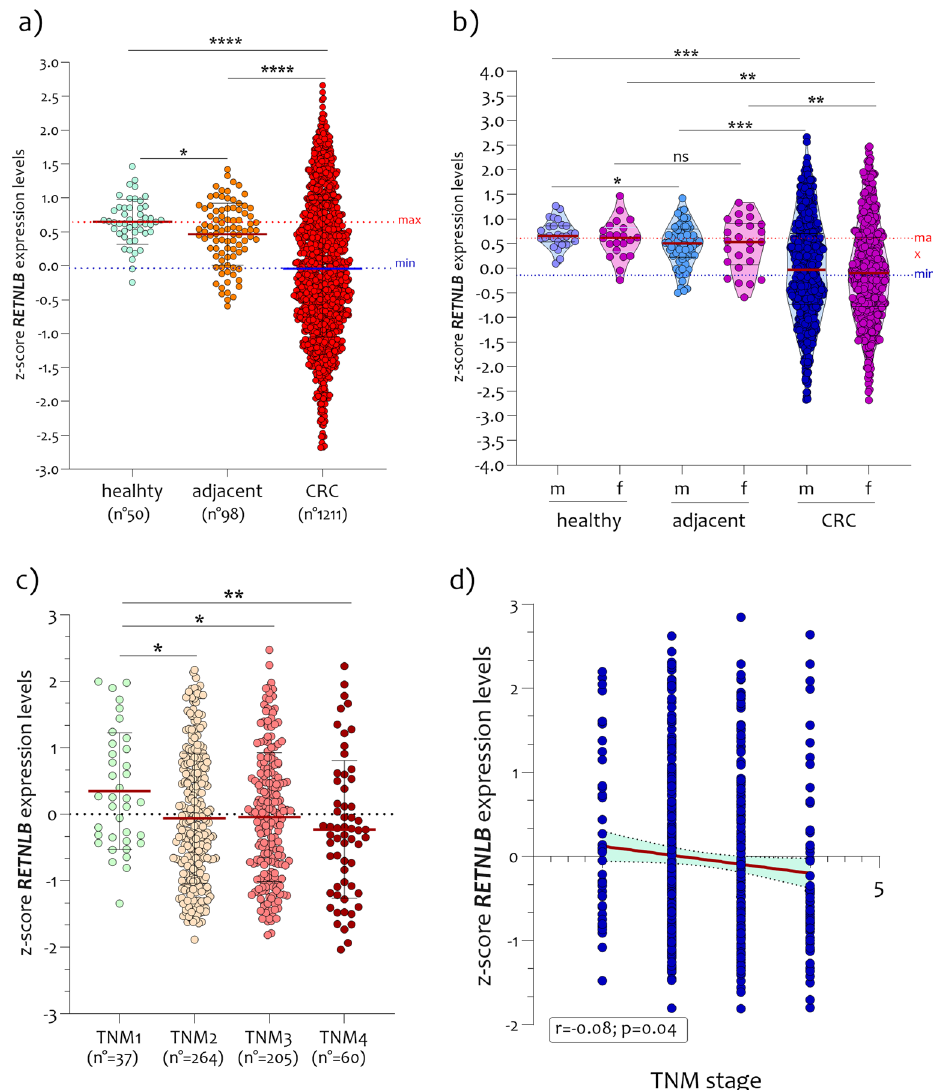
Figure 1. Expression levels of RETNLB in CRC datasets. ( a ) Reduction of RETNLB expression in CRC biopsies compared to NHM and NPDM; ( b ) Expression analysis of RETNLB in CRC biopsies according to the patient’s sex; ( c ) Expression of RETNLB in CRC biopsies according to the TNM stage stratification; ( d ) Correlation analysis between the RETNLB expression levels and TNM stage in CRC biopsies. The dashed lines indicate the maximum and minimum mean values. Data are expressed as z-score intensity expression levels (means and SD) and presented as dot plots. P values < 0.05 were considered as statistically significant (*p < 0.01; ****p <